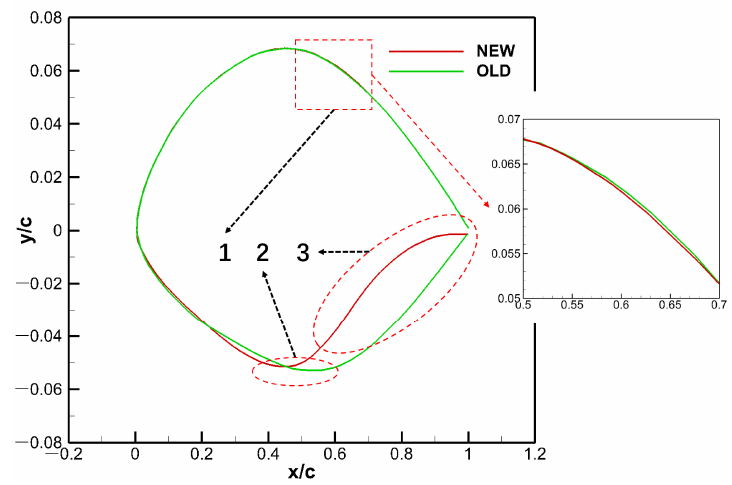
Figure 24. Result of airfoil design.